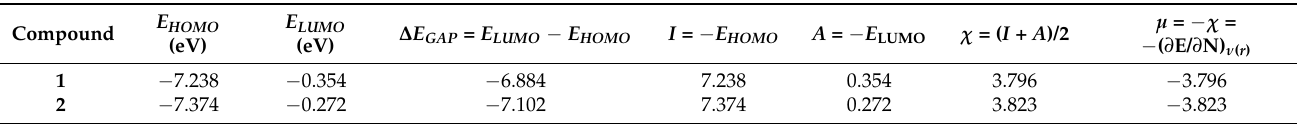
Table 2. Quantum chemical parameters of the isolated compounds 1 – 2 from T. ruticarpum calculated by NBO analysis at level BP86/def2-TZVPP including HOMO energy ( E HOMO ), LUMO energy ( E LUMO ), energy gap ( ∆ E GAP ); ionization potential ( I ); electron affinity ( A ); electronegativity ( χ ); chemical potential ( µ